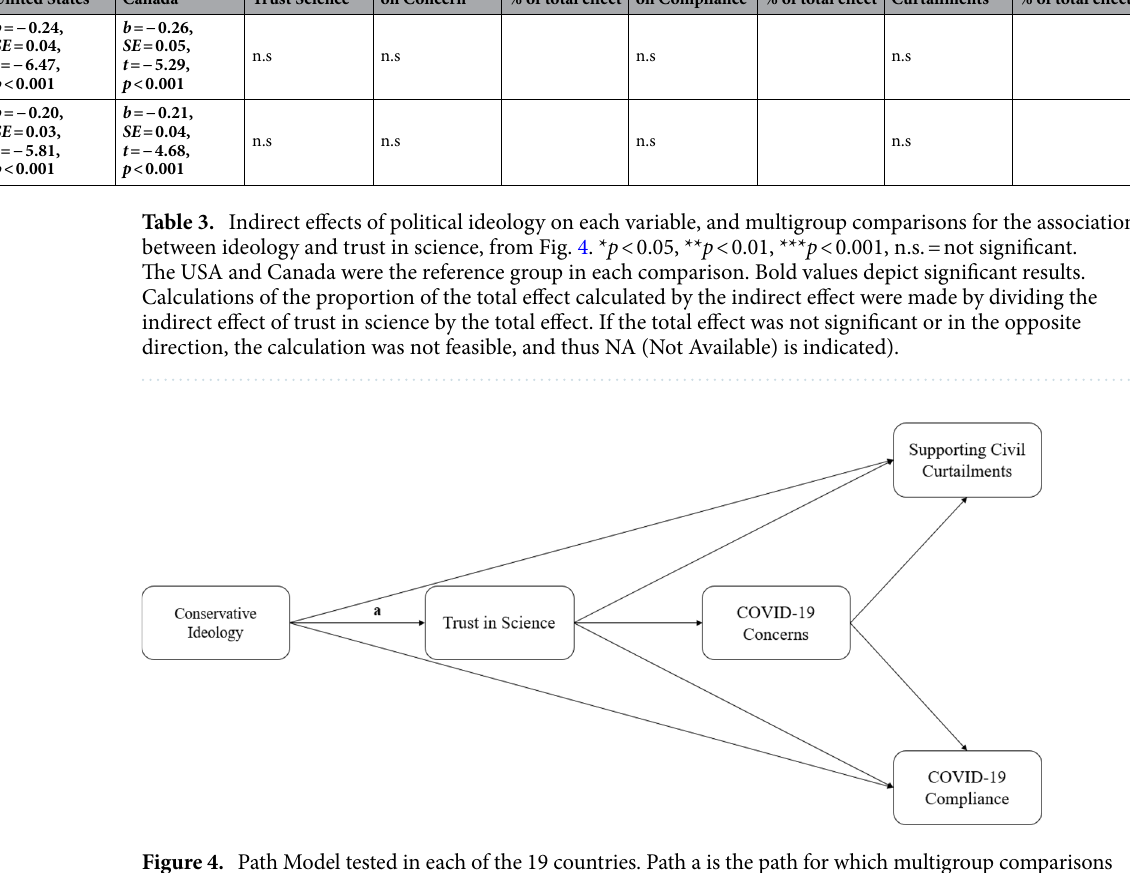
Figure 4. Path Model tested in each of the 19 countries. Path a is the path for which multigroup comparisons were estimated. Figure was constructed in Microsoft